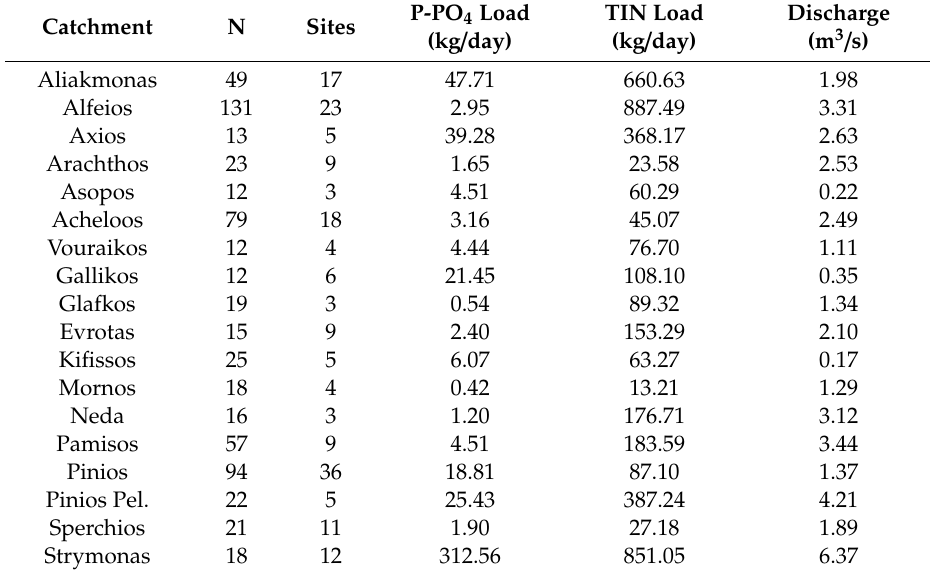
Table 3. Estimated average rates of loads of phosphate and total inorganic nitrogen that the rivers receive. Average discharge measured at site is also